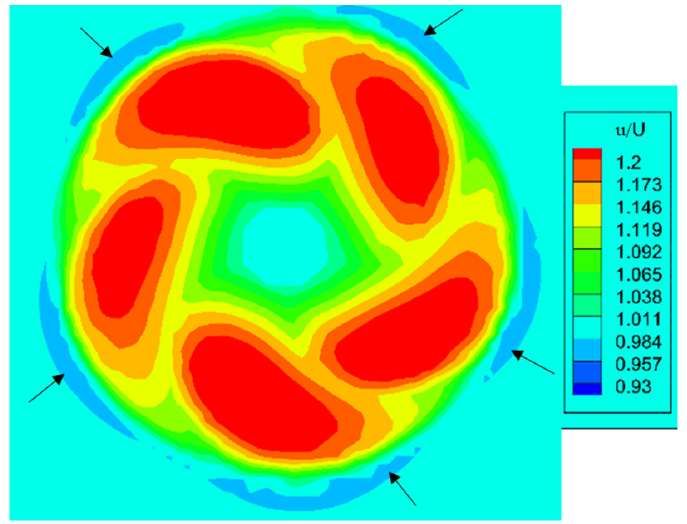
Figure 15. KP505 axial velocity distribution at x = 0.0.098 R behind the propeller for the rotating blade body model. The propeller center is at x = 0. The arrow points out the low-velocity area outside blade tip.